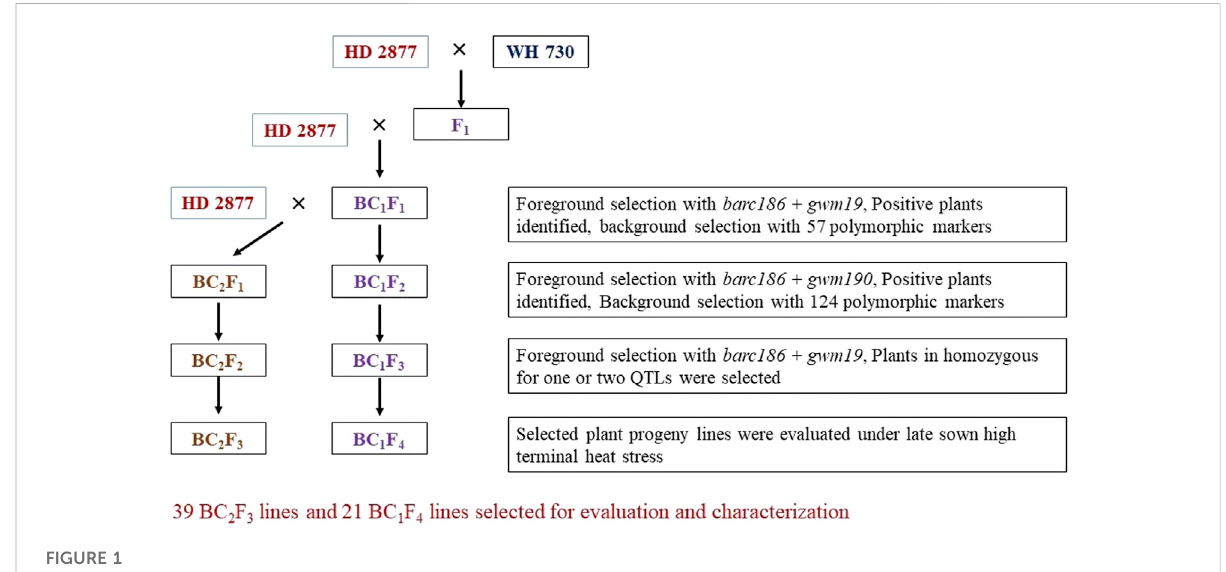
FIGURE 1 MABB scheme for the improvement of HD2733 using WH730 as a donor for heat-tolerance QTLS.